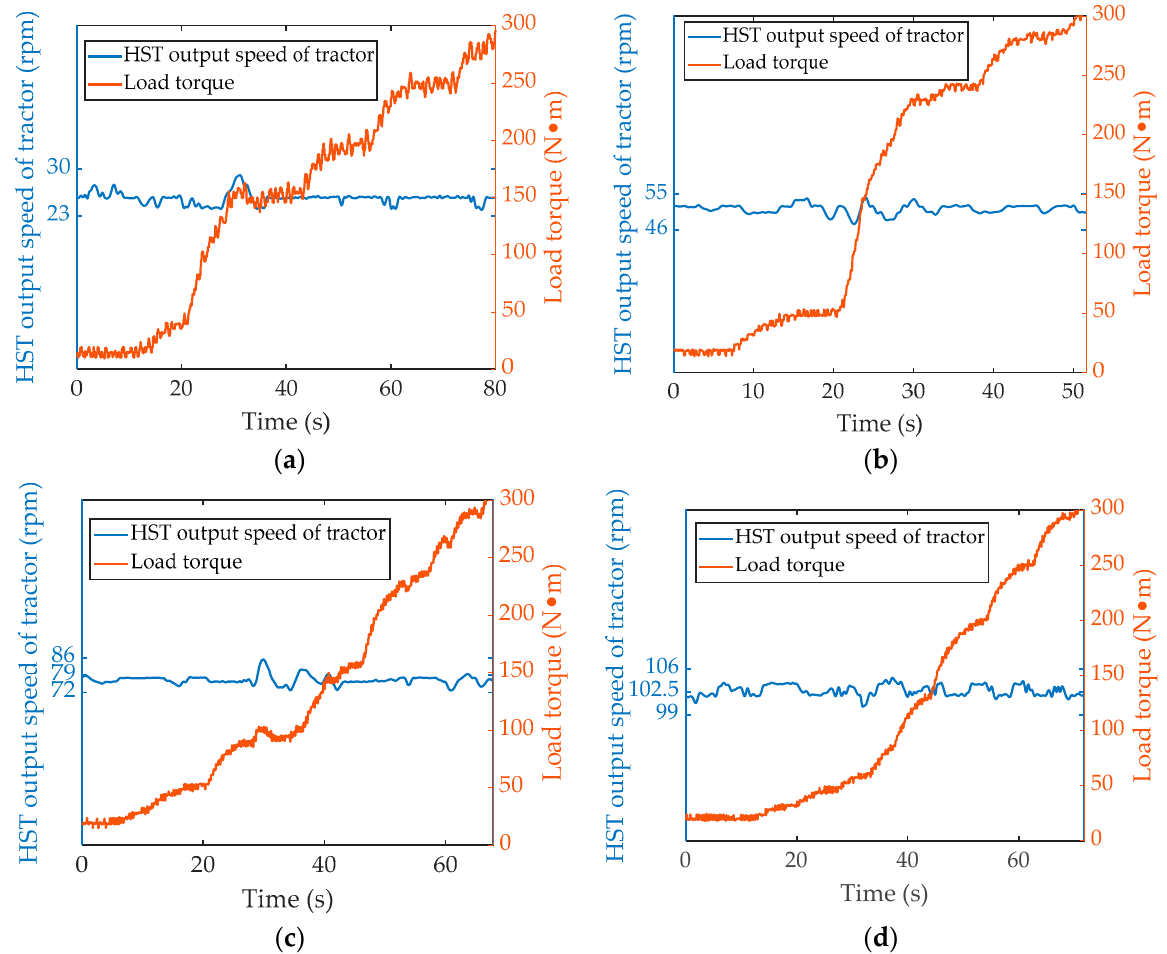
Figure 14. Variation curve of the system response and load in the PID control. ( a ) Target speed: 25.75 rpm; ( b ) target speed: 51.50 rpm; ( c ) target speed: 77.25 rpm; ( d ) target speed: 103 rpm.